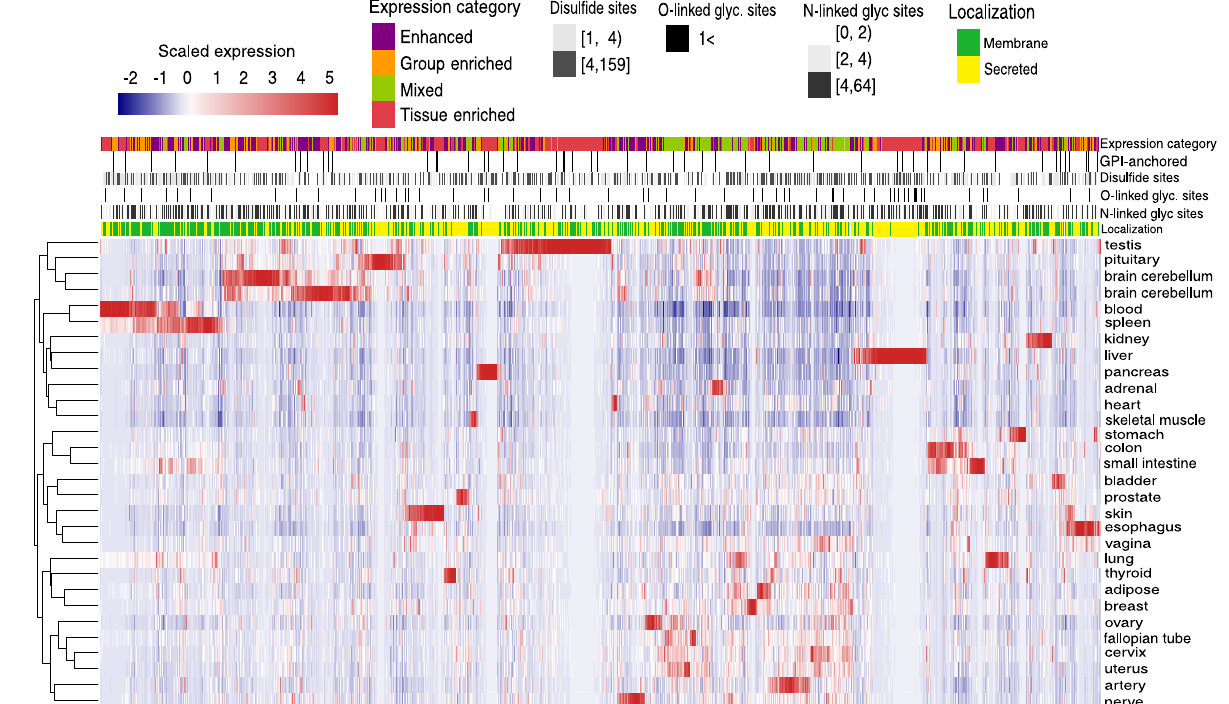
Fig. 5 Hierarchical clustering of human tissue-speci fi c secretome and membrane proteome expression and their PTMs. Each row represents a tissue and each column a tissue-speci fi c secreted or membrane protein-encoding gene. Z -scores are scaled FPKM values for the expression of a given gene in a given tissue vs. other tissues. The annotation bars above the heatmap provide information regarding the expression category, number of disul fi des, N-linked or O-linked glycosylation sites, GPI-anchored sites, and localization. The number of the sites are discretized to separate low, medium, and high number of PTM